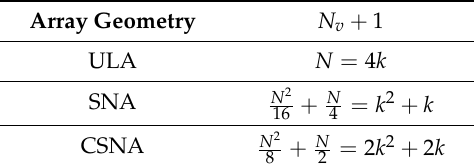
Table 2. The value of N v + 1 for ULA, SNA and